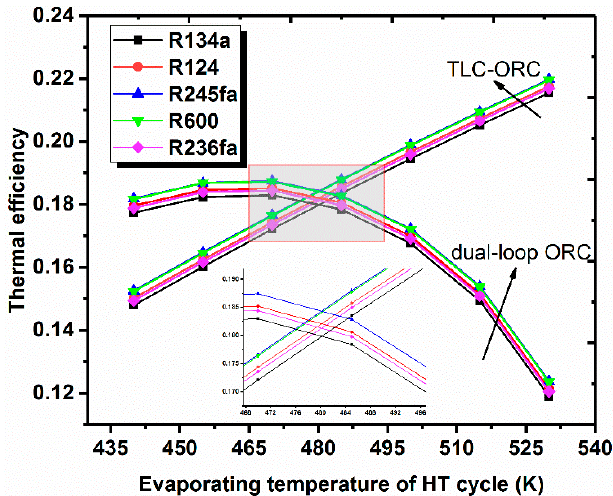
Figure 11. Comparison of thermal efficiency between the two systems under different LT working fluids and T HT,evap .